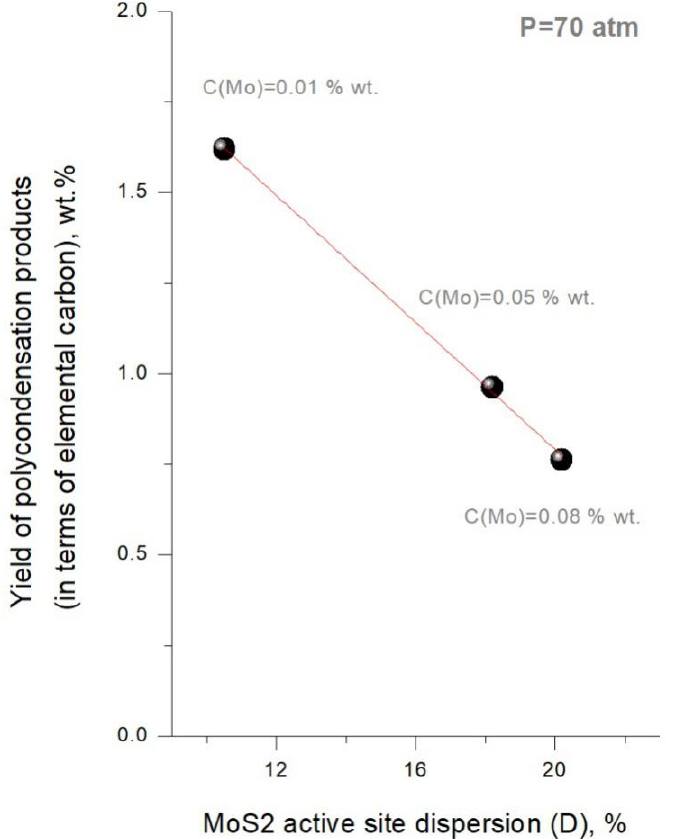
Figure 4. Correlation between the yield of polycondensation products and MoS 2 active sites dispersion in precursor loading variation tests.